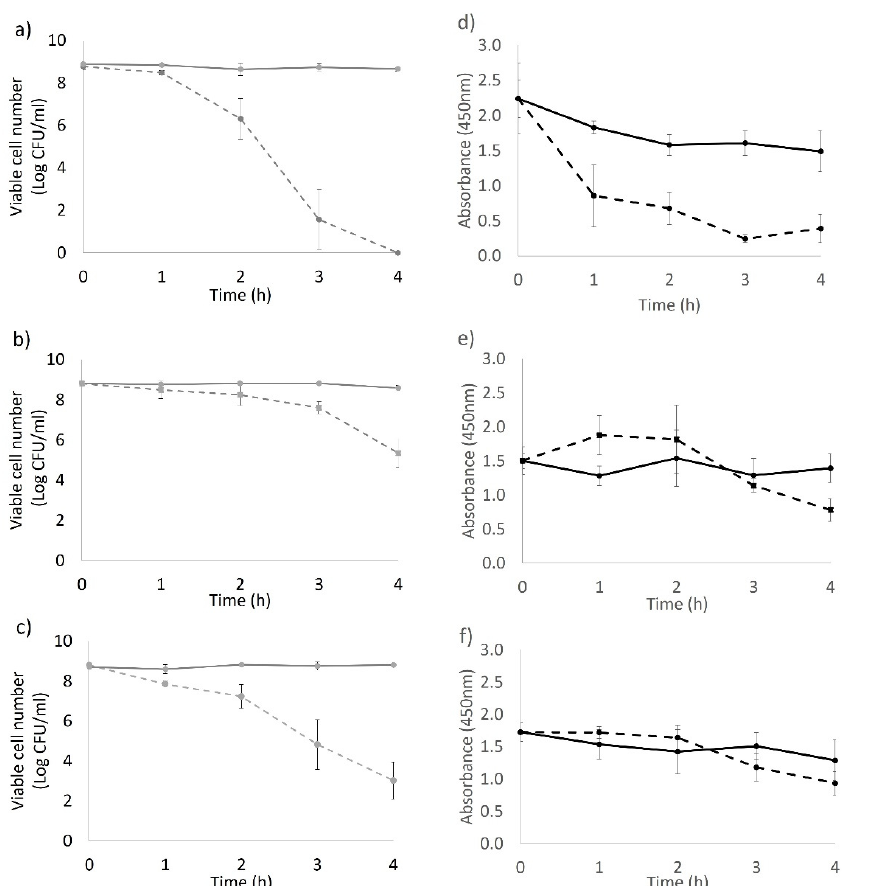
Figure 1. Cytotoxicity/antimicrobial efficacy of 4-h LED application against stationary phase cells of three C. sakazakii strains. ( a ) Viable cell counts of BAA894; ( b ) viable cell counts on ES191; ( c ) viable cell counts of AGRFS2961; ( d ) XTT assay on BAA894; ( e ) XTT assay on ES191; ( f ) XTT assay on AGRFS2961; solid line represents control groups and dash line represents LED treated groups.